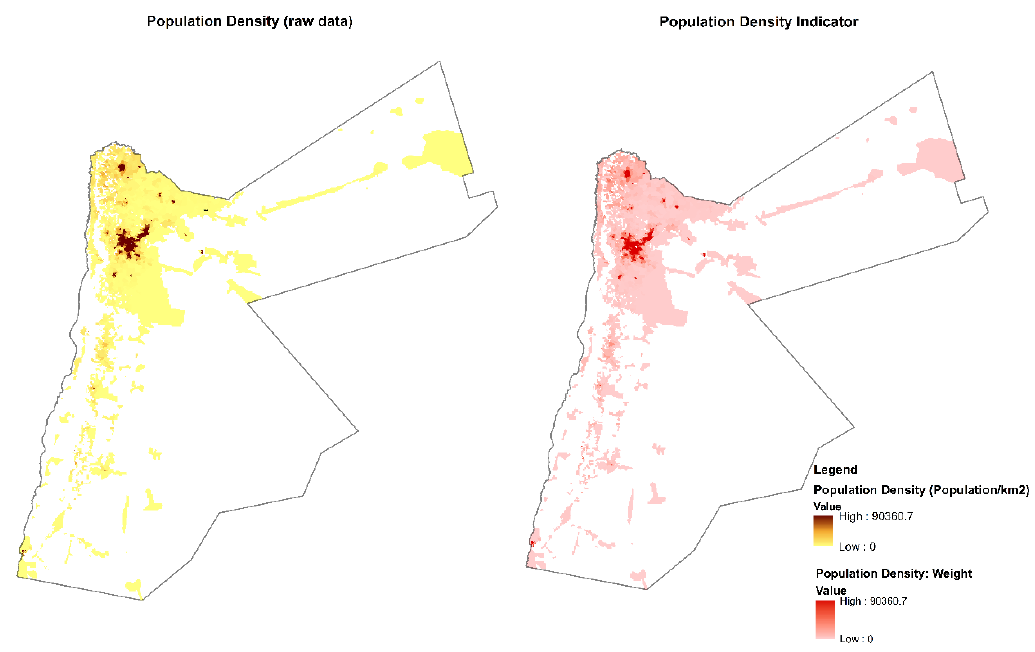
Figure 5. Population Density Indicator.